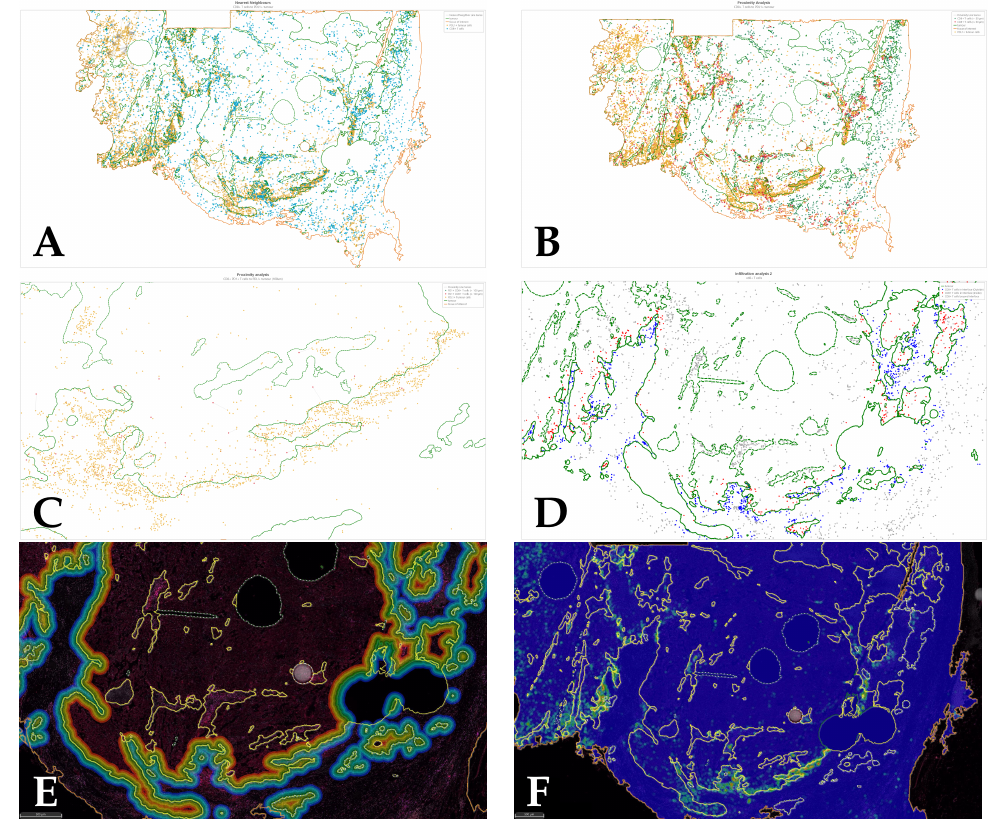
Figure 4. ( A ) Nearest neighbour analysis quantified the number of PD-1 + T cells nearby each PD-L1 + tumour cell within a specific radius; ( B ) proximity analysis quantified the distance of PD-1 + T cells from PD-L1 + tumour cells; ( C ) proximity analysis, closer view; ( D ) infiltration analysis quantified the density of PD-1 + T cells in 5 distance bands within and outside the tumour margin; ( E ) infiltration analysis, distance bands visualised on the real image; ( F ) density heatmap showing PD-L1 + tumour cells distributed mainly on the tumour